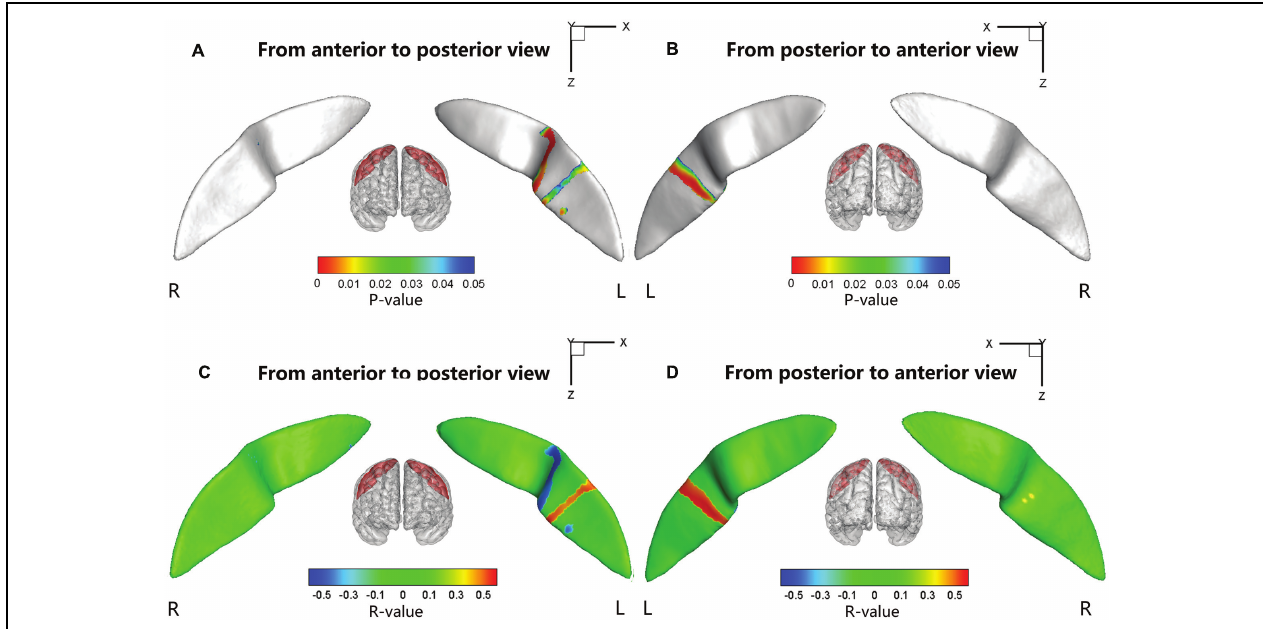
FIGURE 5 | The correlation between the node-based sulcal profiles and the hyperactivity-impulsivity scores using age and gender as the covariates. The focal regions with significant positive correlations ( t < 0, P < 0.05) were mapped onto the average surface of the CS. Notably, we first defined the regions showing significant differences in the